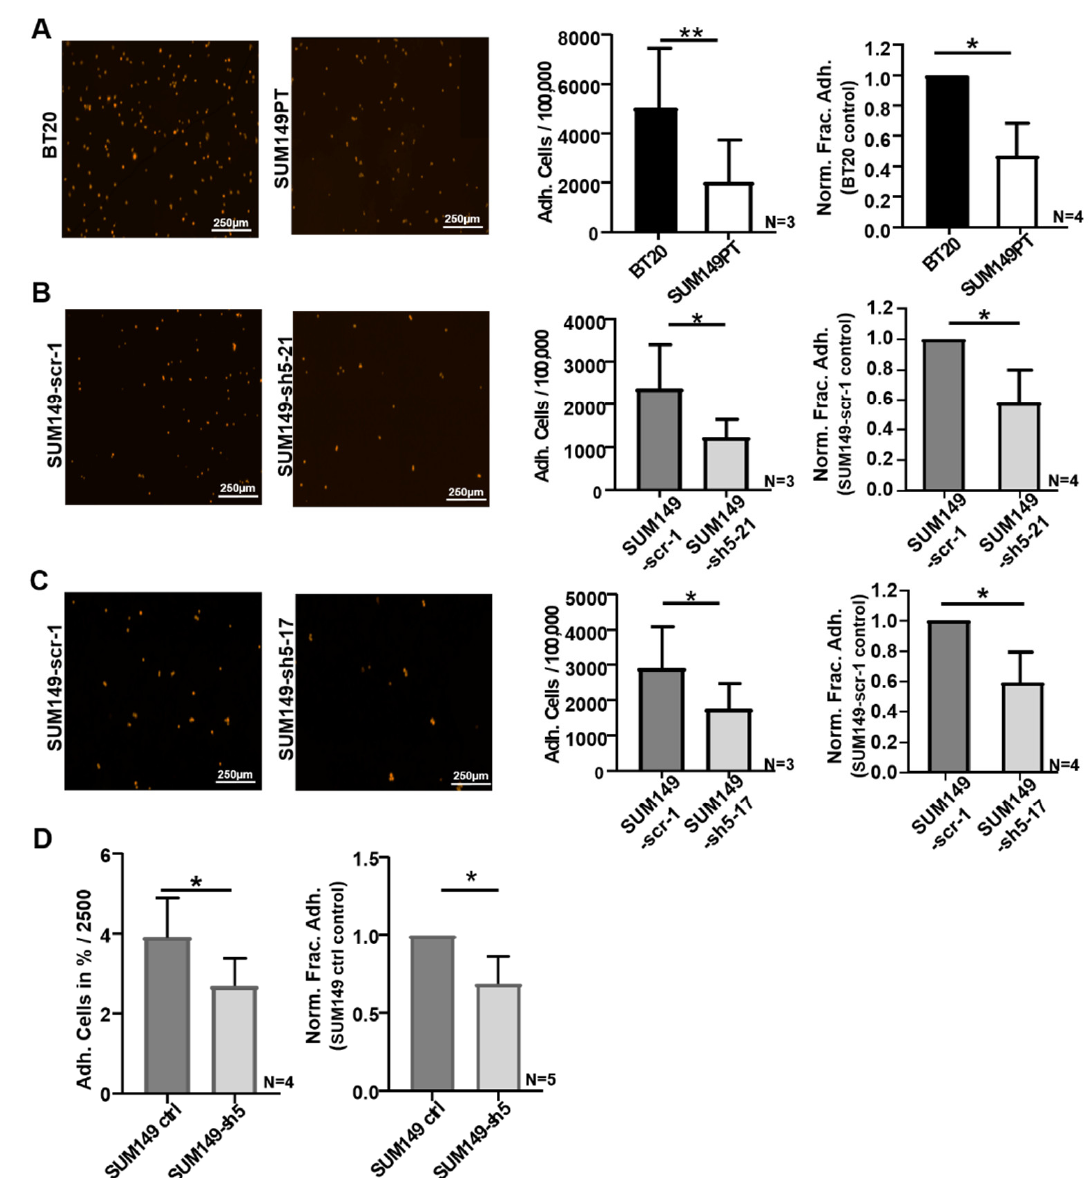
Figure 2. VE-cadherin influences the adhesion of BT20, and SUM149 cells to HUVEC. ( A – C ) Identical cell numbers (100,000) of fluorescently labelled tumor cells were incubated on HUVEC monolayers for 30 min. Immunofluorescence images as used for cell counting by Fiji software (left panels); Number of tumor cells adherent to HUVEC of the 100,000 tumor cells seeded (Adh. Cells/100,000); Normalized Fraction Adhesion (Norm. Frac. Adh.) to control (right panels). ( D ) Identical numbers (2500) of fluorescently labelled tumor cells were incubated on HUVEC monolayers for 60 min. Fluorescence intensity measurement was performed. Tumor cell number correlated to fluorescence intensity and was determined by RFU standard curve (Supplementary Figure S1). Adherent tumor cells in percent of the 2500 tumor cells seeded (Adh. Cells in %/2500) and the Normalized Fraction Adhesion (Norm. Frac. Adh.) to control; Bars represents standard deviation; * p ≤ 0,05; ** p ≤ 0.01; statistical analysis was conducted using unpaired Welch’s t